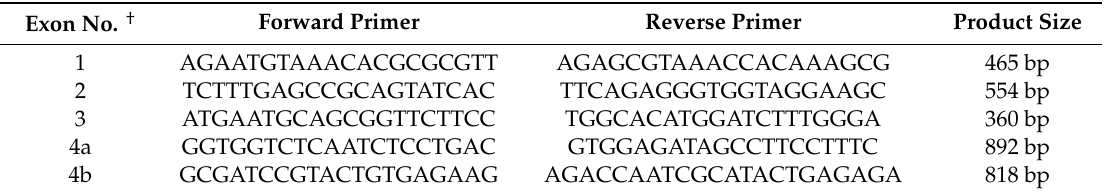
Table 1. Sequence and product size of the PCR primers used for DNA